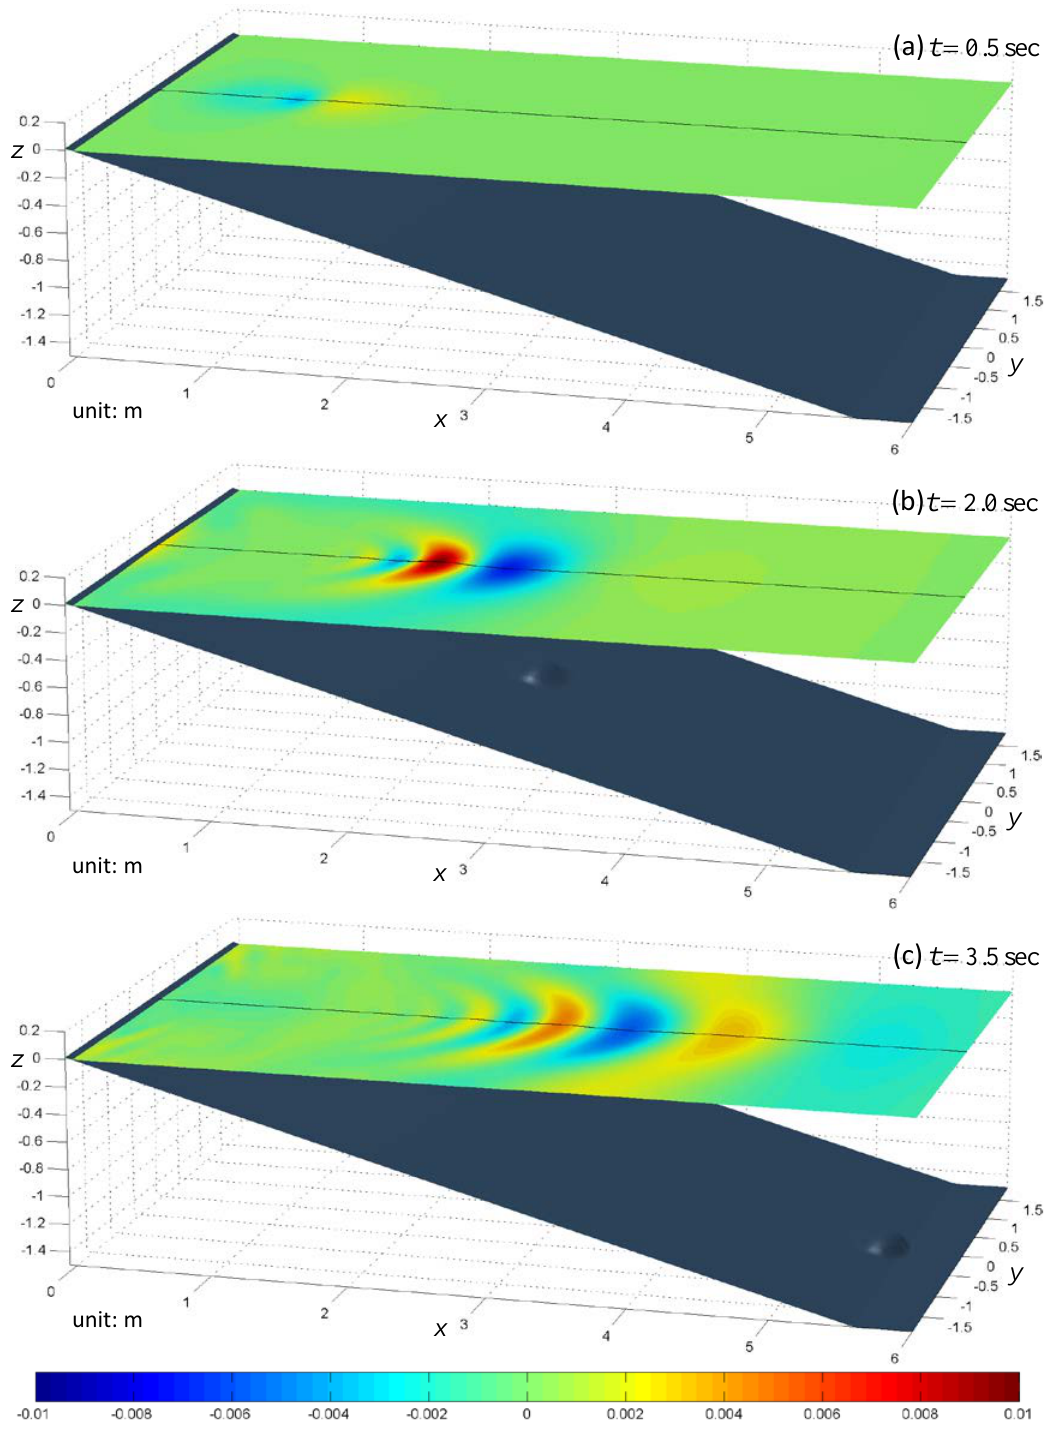
Figure 8. Snapshots of the free surface elevation in case 3. ( a ): t = 0.5 sec; ( b ): t = 2.0 sec; ( c ): t = 3.5 sec.